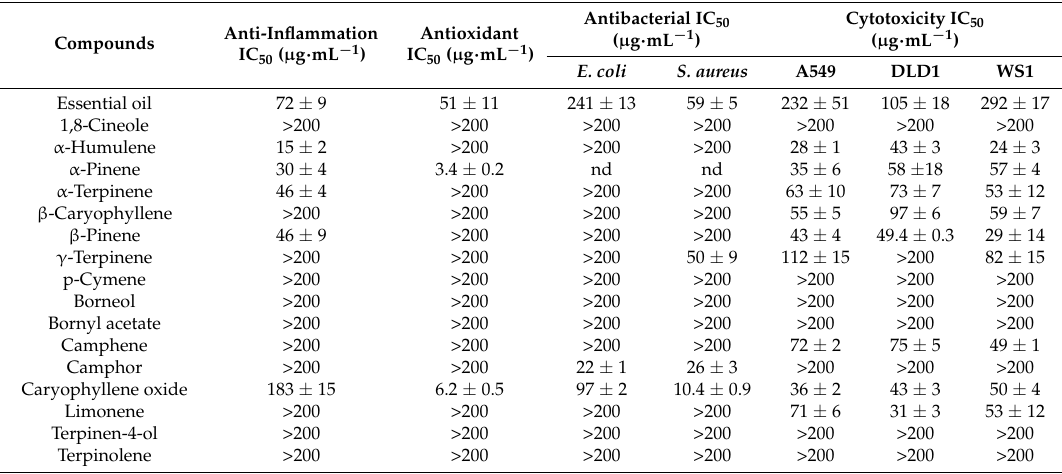
Table 2. Anti-inflammation, antioxidant, antibacterial, and cytotoxic activities of T. vulgare essential oil and its main constituents